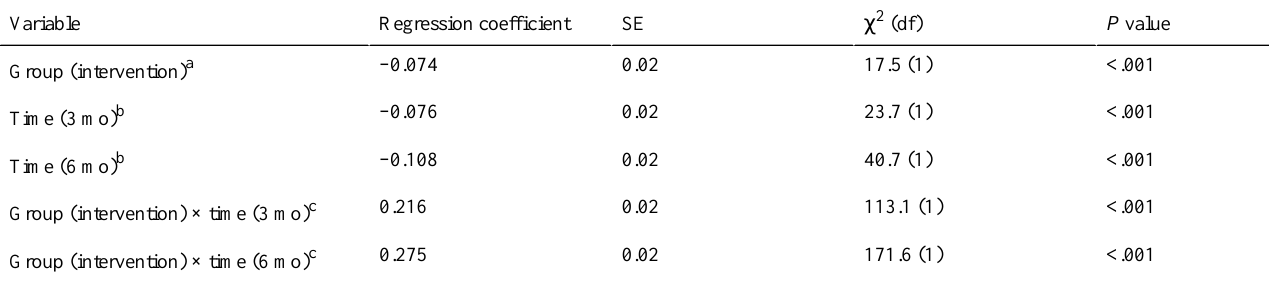
Table 4. Generalized estimating equation analysis of the effect of the intervention on EuroQol five-dimension self-report questionnaire scores.